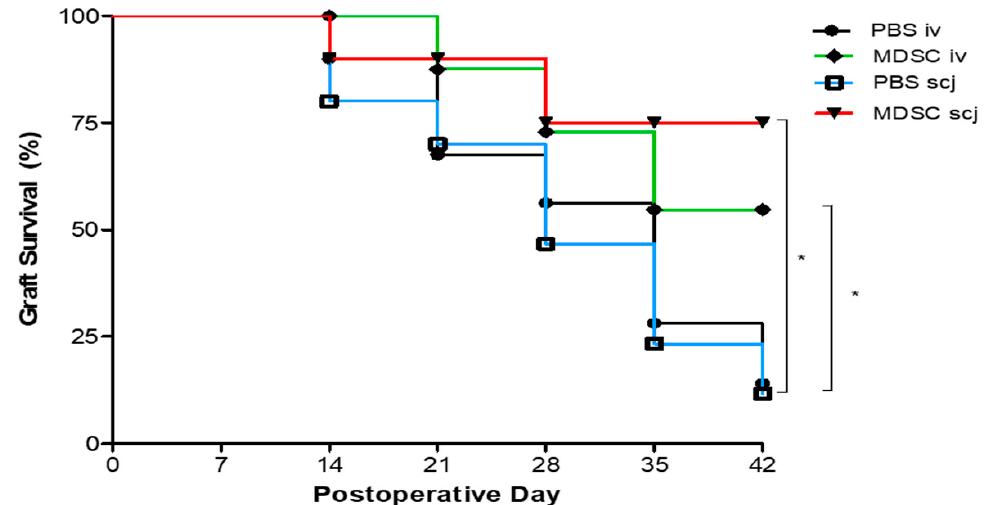
Figure 1. Comparison of corneal allograft survival according to the local and systemic administration of MDSCs. BALB/c (recipient) corneas were engrafted orthotopically onto C57BL/6 (donor) corneas by using PBSiv ( n = 9), MDSCiv ( n = 9), PBSscj ( n = 11), and MDSCscj ( n = 11). Locally and systemically injected MDSCs (scj, iv) groups displayed significantly better corneal allograft survival than PBS-injected (scj, iv) groups (* p < 0.05) for 42 days. Kaplan–Meier survival curves were obtained via the log-rank test for the statistical comparison of four groups.